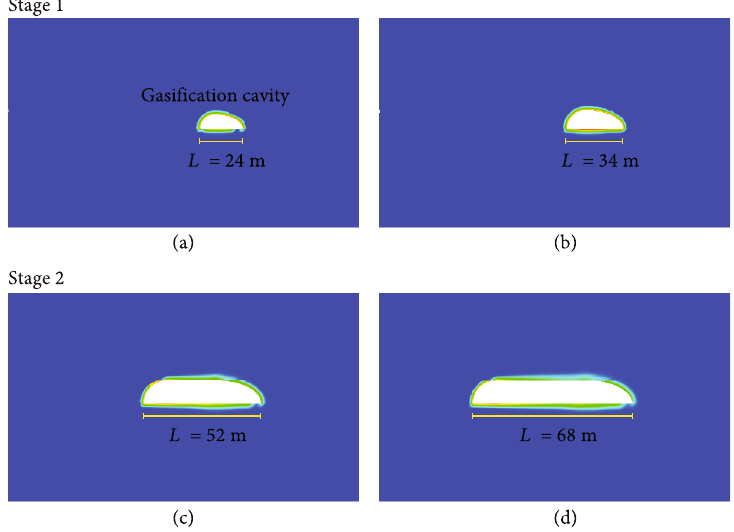
Figure 9: Temperature distribution characteristics of combustion cavity in stage1 and stage 2, respectively.